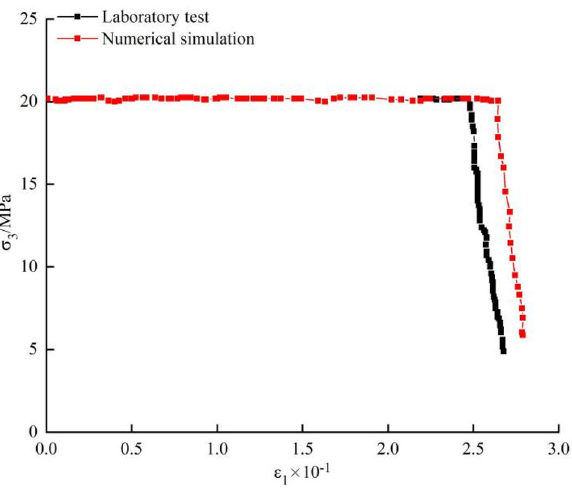
Figure 16. Confining pressure-axial strain curves in laboratory tests and PFC